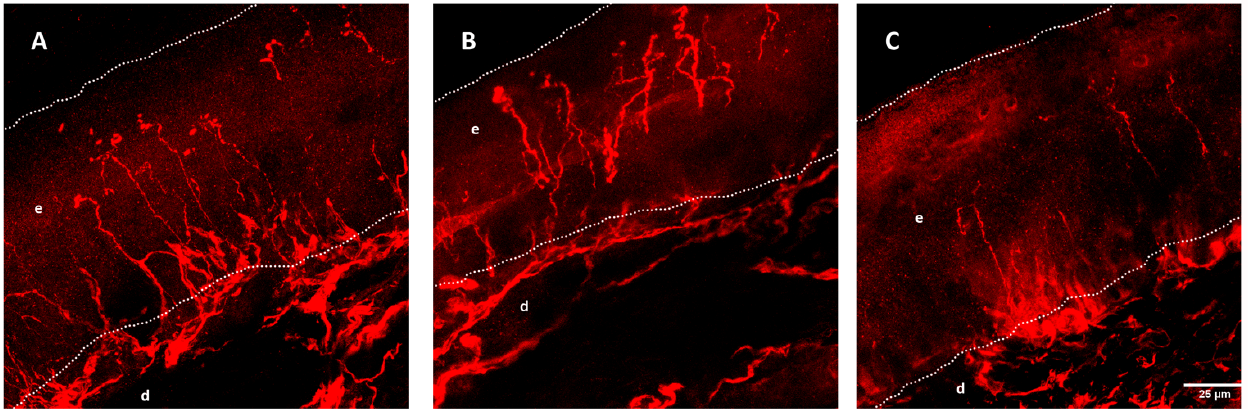
Figure 3. Intraepidermal nerve fiber (IENF) density from wild-type ( A ), SOD1 G93A mice of 8 ( B ), and 16 weeks ( C ). Dotted lines mark the limits of the epidermis (e) and dermis (d). IENF fibers are marked with PGP9.5 and show a decrease over time in the SOD1 G93A mouse. Reprinted/adapted with permission from [167], 2016, John Wiley and Sons.